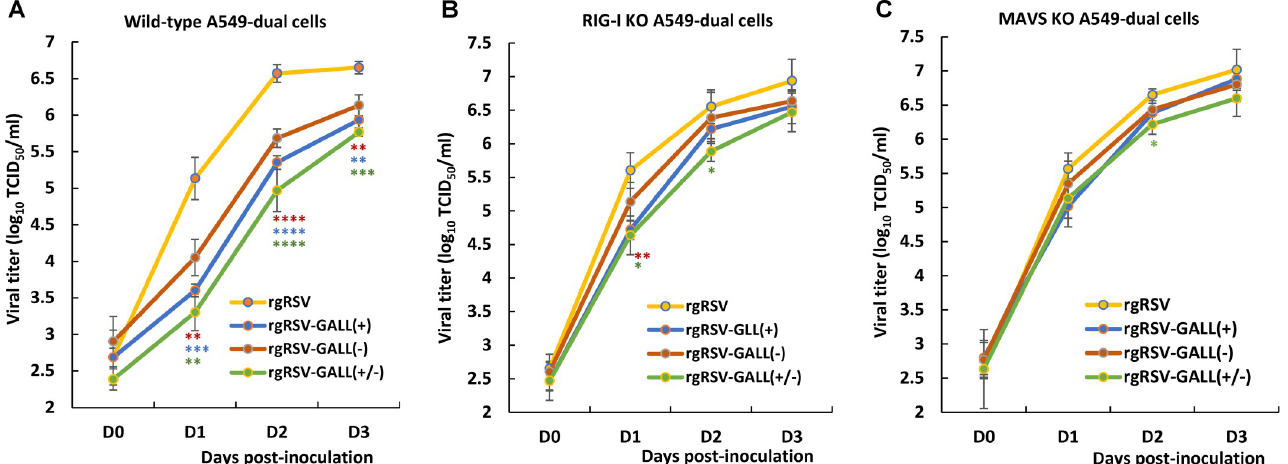
Fig 7. Restoration of the replication of m 6 A-deficient rgRSVs in RIG-I and MAVS-knockout A549 cells. Replication kinetics of m 6 A-deficient rgRSVs in WT ( A ) RIG-I-knockout ( B ) or MAVS-knockout ( C ) A549 cells. Cells in 24-well plates were infected by each rgRSV at an MOI of 1.0, virus was harvested at day 0–3 post-infection, and viral titer was determined by TCID 50 assay in HEp-2 cells. Viral titers are the geometric mean titer (GMT) of three independent experiments ± standard deviation. Viral titer of each rgRSV at each time point was compared with that of the parental rgRSV. Statistical significance was determined by two-sided Student’s t -test. � P < 0.5, �� P < 0.01, ��� P < 0.001, ���� P < 0.0001.